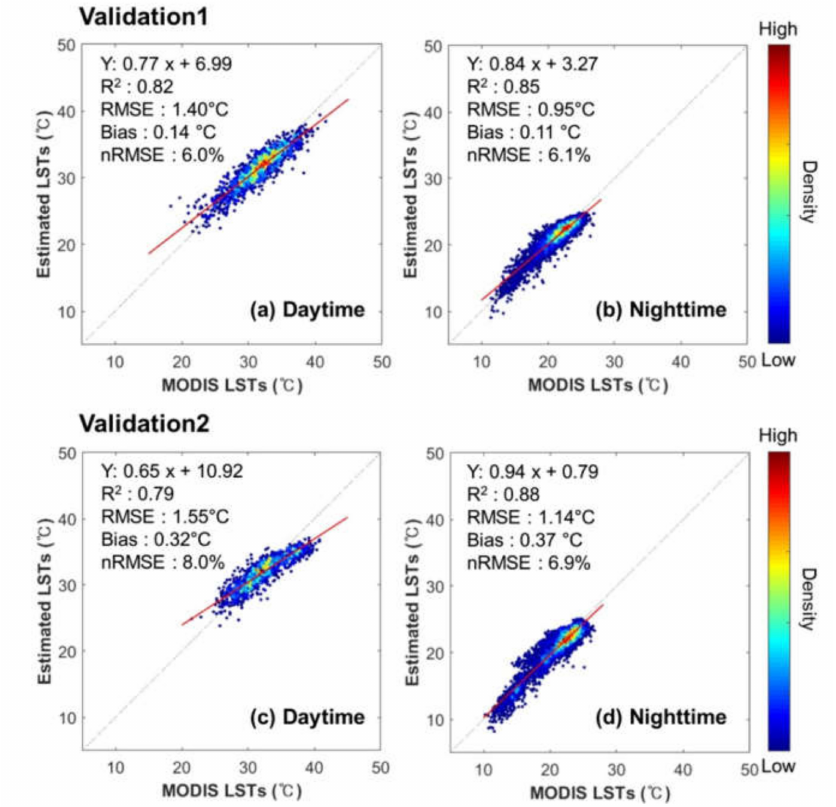
Figure 5. Density scatter plots between the estimated and 10 km moderate-resolution imaging spectroradiometer (MODIS) LSTs for scheme 1(S1) from two validation results for daytime and nighttime. The color ramp from blue to red corresponds to increasing point density. Black dashed lines show the regression line and red solid lines represent the line of identity (y =